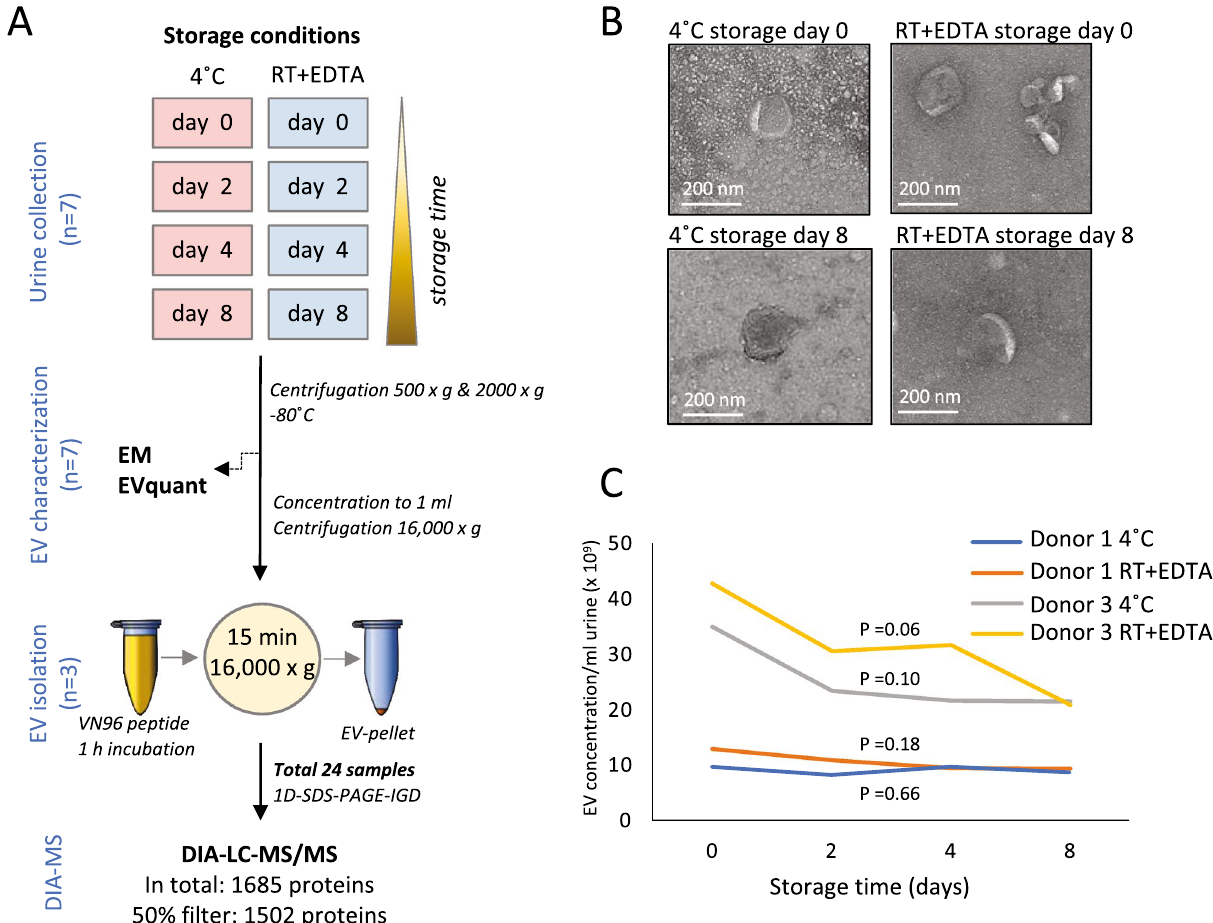
Figure 1. Schematic overview of urine storage conditions. ( A ) Schematic overview of the two storage methods of urine from seven different donors. Urine was stored either at 4 °C or with EDTA at RT for up to 8 days. EV characterization was performed on all seven donors using EM and EVQuant. Urinary EVs were isolated from three donors and proteomes were measured using DIA-LC–MS/MS. ( B ) EM pictures of EVs directly after urine collection, or after 8 days of storage using the two different storage conditions. ( C ) Effect of storage time and protocol on the concentration of EVs as measured using the EVQuant